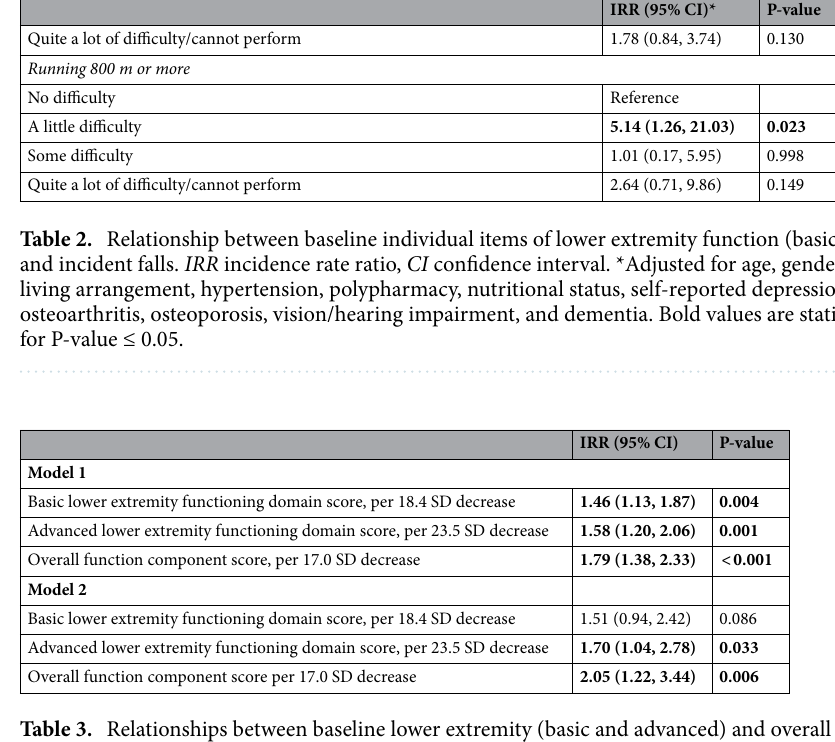
Table 3. Relationships between baseline lower extremity (basic and advanced) and overall function score with incident falls. Overall function component score: made up of three sub domains, upper extremity basic lower extremity and advanced lower extremity; Model 1: adjusted for age, gender, ethnic group; Model 2: additionally, adjusted for living arrangement, hypertension, polypharmacy, nutritional status, self-reported history of depression, stroke, osteoarthritis, osteoporosis, vision/hearing impairment, and dementia. IRR incidence rate ratio, CI confidence interval, SD standard deviation. Bold values are statistically significant for P-value ≤